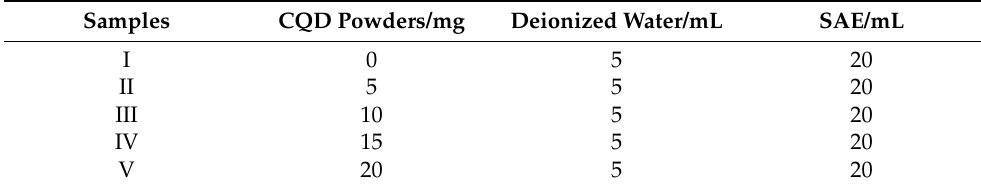
Table 2. Proportion of experimental materials for the preparation of SAE coating films with various concentrations of